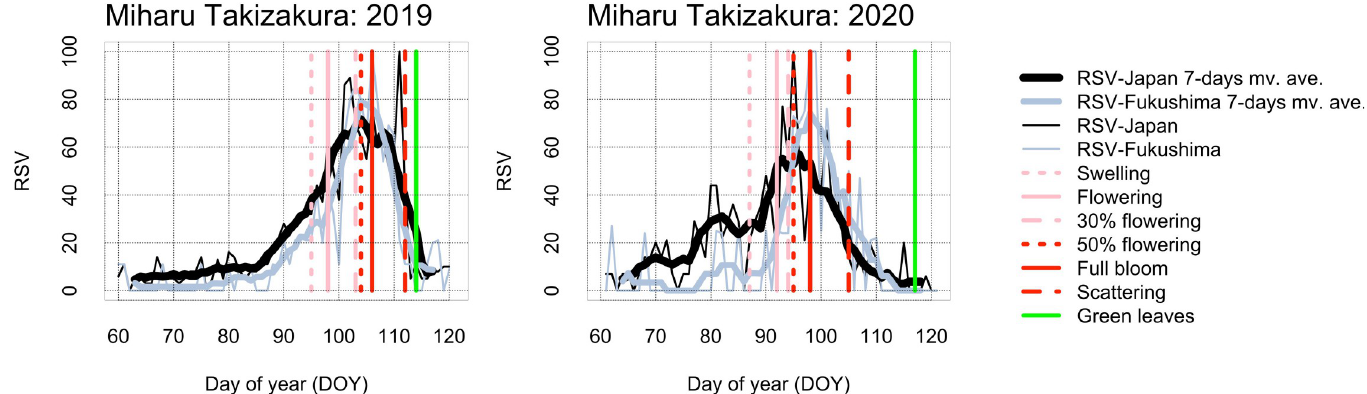
Fig 3. For Miharu Takizakura, the relationship between time-series of RSV searched by “Topics” in all Japan and Fukushima and flowering information published on websites from 2019 to 2020. For more result regarding the relationship from 2016 to 2018, see S1 Fig. mv. ave.: moving average.